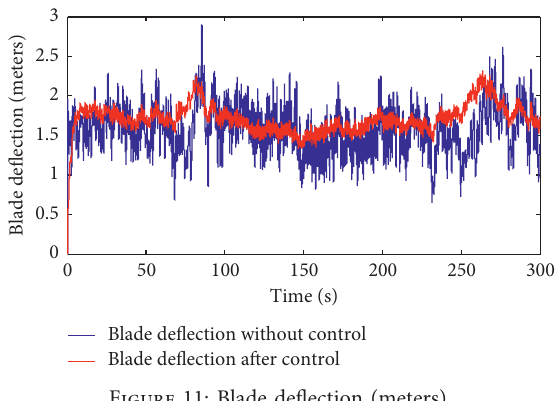
Figure 11: Blade deflection (meters).